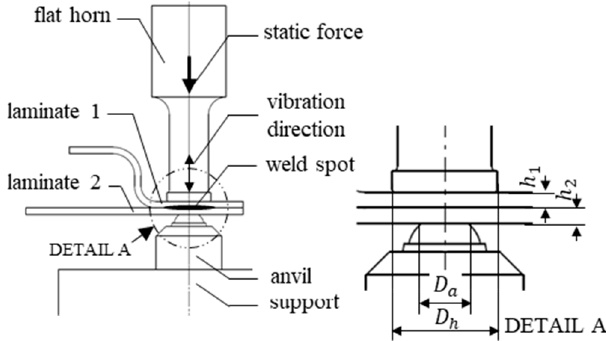
Figure 1. The configuration of the ultrasonic spot welding. Illustration of the main components and dimensions.